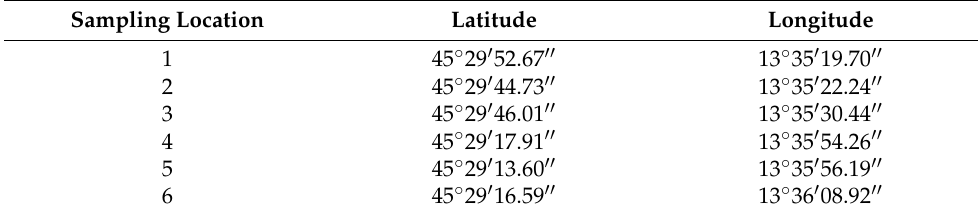
Figure 2. Sampling locations in the Seˇcovlje Salina: (1–3) Piccia area, (4 and 5) crystallisation basin and (6) Poslužnica area. Table 1. Sampling positions in the investigated